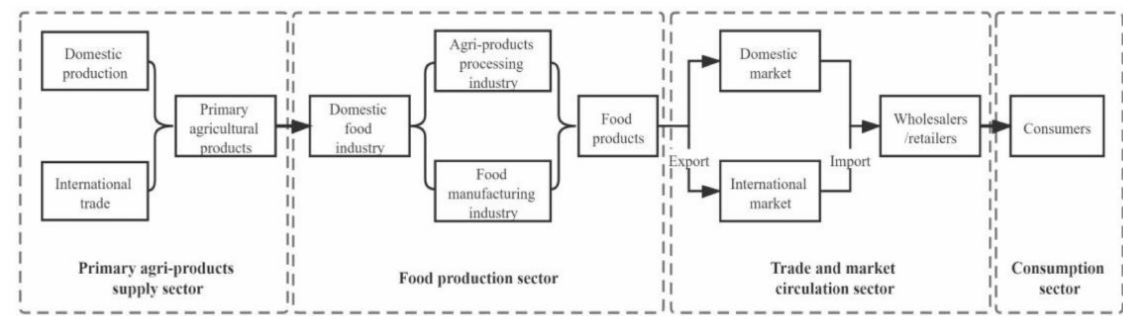
Figure 1. The major sectors of the food supply